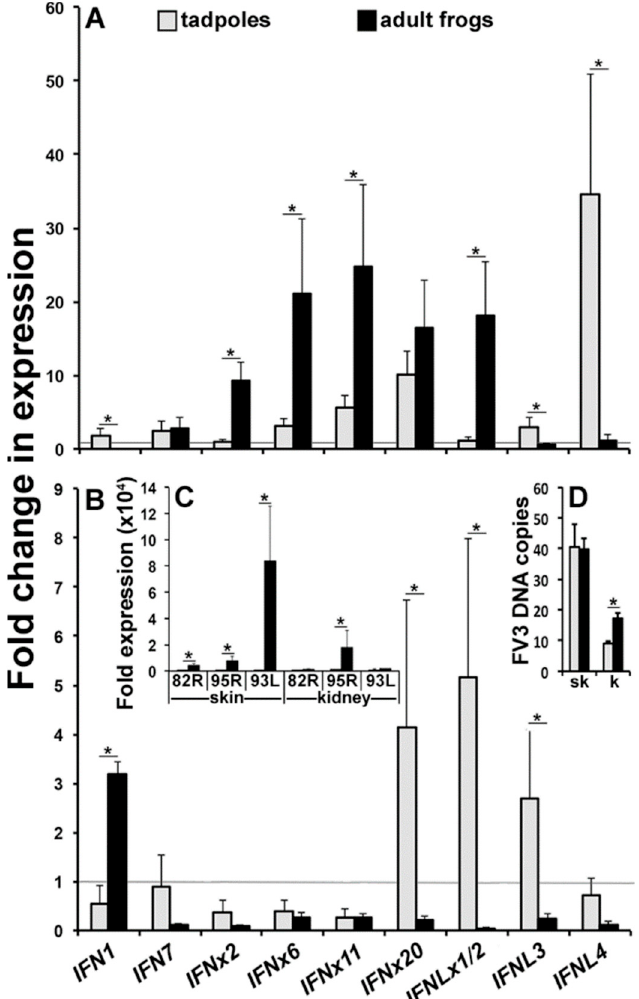
Figure 5. Tadpoles and adult X. laevis mount distinct IFN responses to FV3. Tadpoles (Nieuwkoop and Faber, NF stage 54, N = 5) and adult frogs (1 year old, N = 5) were challenged by water bath with 10 6 PFU of FV3 per ml of water or mock infected (water), and after 6 h of infection, their ( A ) skin and ( B ) kidney tissues were examined for the IFN gene expression, ( C ) FV3 gene expression, and ( D ) FV3 DNA viral loads. All of the gene expressions were compared to the GAPDH control, normalized against the mock-infected expression of the respective genes within given tissues. All of the results are presented as means + SEM. Significant differences between the respective experimental groups are denoted by overhead lines and asterisks (*). p < 0.05.